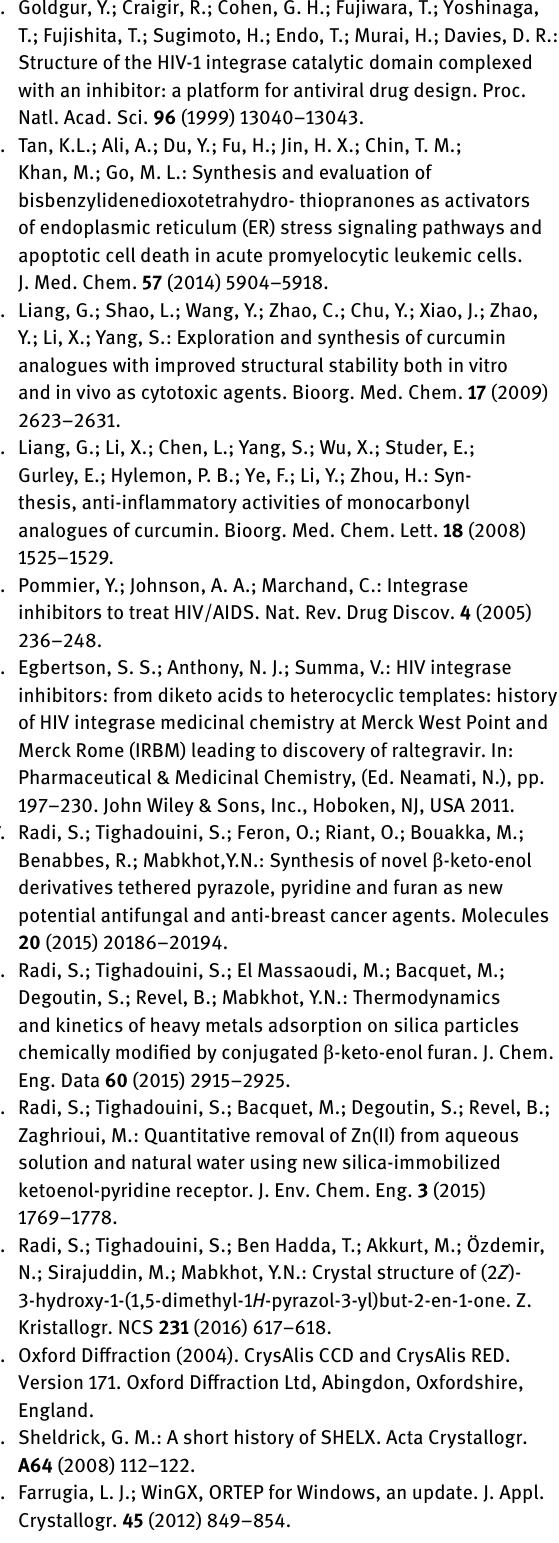
Table 2: Fractional atomic coordinates and isotropic or equivalent isotropic displacement parameters (Å 2